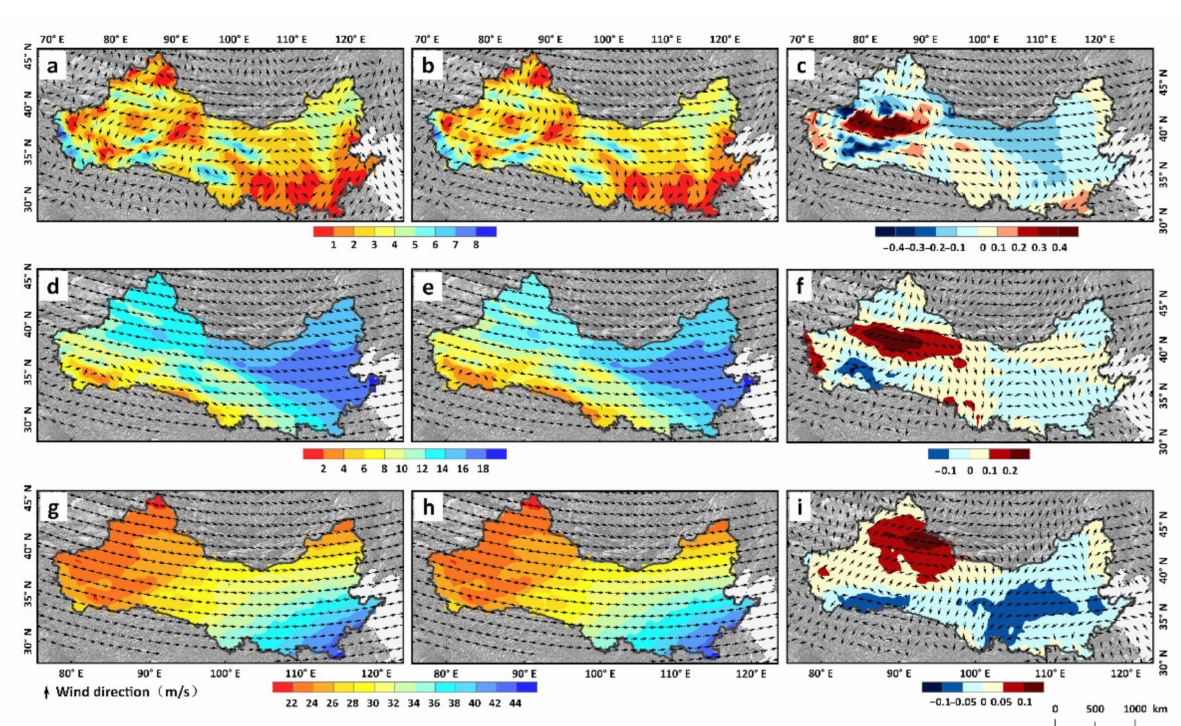
Figure A5. Circulation changes in spring under the influence of sand and dust: ( a ) Spring-averaged circulation at 1000 hPa isobaric surface with the influence of sand and dust; ( b ) Spring-averaged circulation at 1000 hPa isobaric surface without the influence of sand and dust; ( c ) Spring differential circulation at 1000 hPa isobar caused by sand and dust; ( d ) Spring- averaged circulation at 500 hPa isobaric surface with the influence of sand and dust; ( e ) Spring-averaged circulation at 500 hPa isobaric surface without the influence of sand and dust; ( f ) Spring differential circulation at 500 hPa isobar caused by sand and dust; ( g ) Spring-averaged circulation at the 200 hPa isobaric surface with the influence of sand and dust; ( h ) Spring-averaged circulation at the 200 hPa isobaric surface without the influence of sand and dust; ( i ) Spring differential circulation at 200 hPa isobaric surface caused by sand and